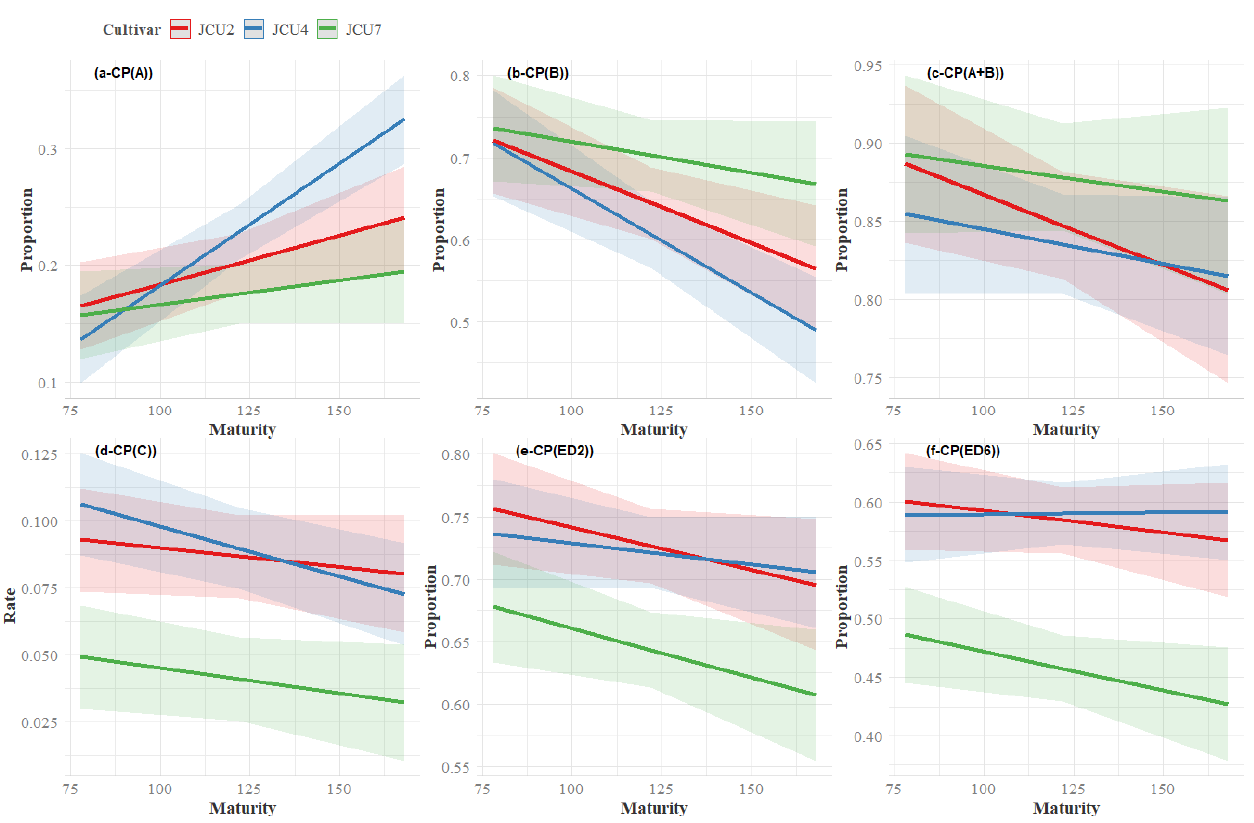
Figure 5. Effect plots for the change in in situ crude protein (CP) degradation of D. virgatus (JCU2), D. bicornutus (JCU4) and D. leptophyllus (JCU7) with maturity. ( a ) A; highly soluble fraction, ( b ) B; potentially degradable fraction, ( c ) A + B; total potentially degradable fraction, ( d ) C; rate of degra-